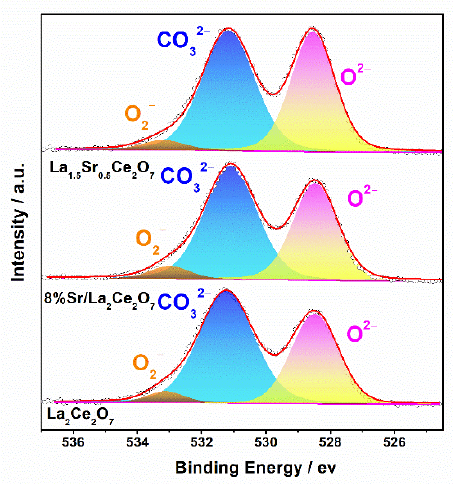
Figure 8. H 2 -TPR profile of the indicated catalysts [89] .